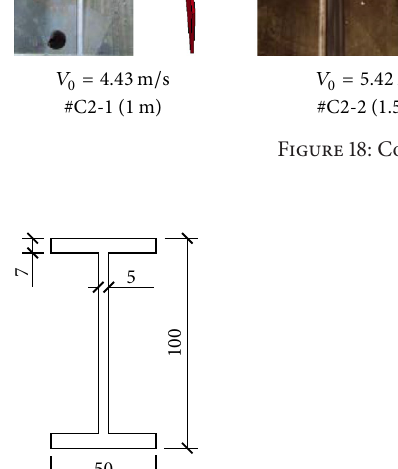
Figure 20: Finite element